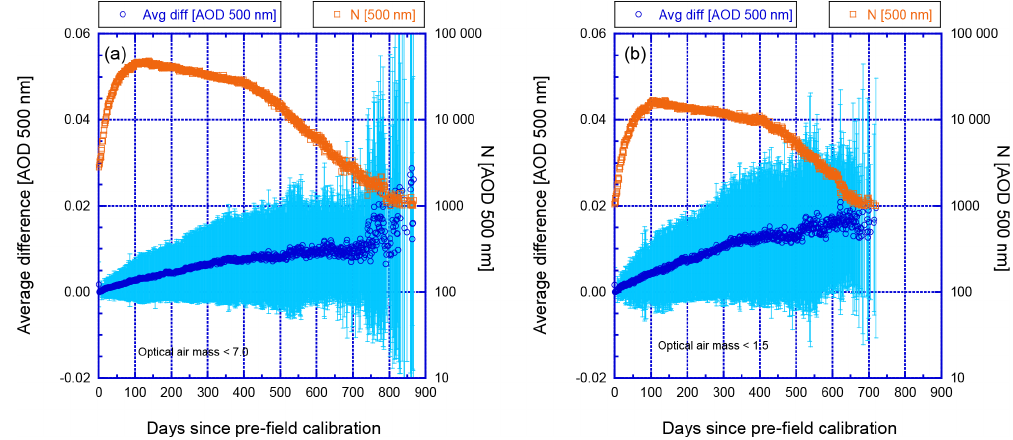
Figure 20. Using data qualified as the Version 3 Level 2.0 aerosol optical depth (AOD) 500nm average difference comparing measurements only with the pre-field calibration applied versus instruments with both the pre-field and post-field calibrations applied from 1993 to 2018. The AOD average differences are provided for the optical air mass 1 . 0 ≤ m < 7 . 0 range in (a) and 1 . 0 ≤ m < 1 . 5 range in (b) . Vertical bars represent the standard deviation for each day bin. The secondary y axis on a logarithmic scale represents the number of measurements of AOD at 500nm for each day